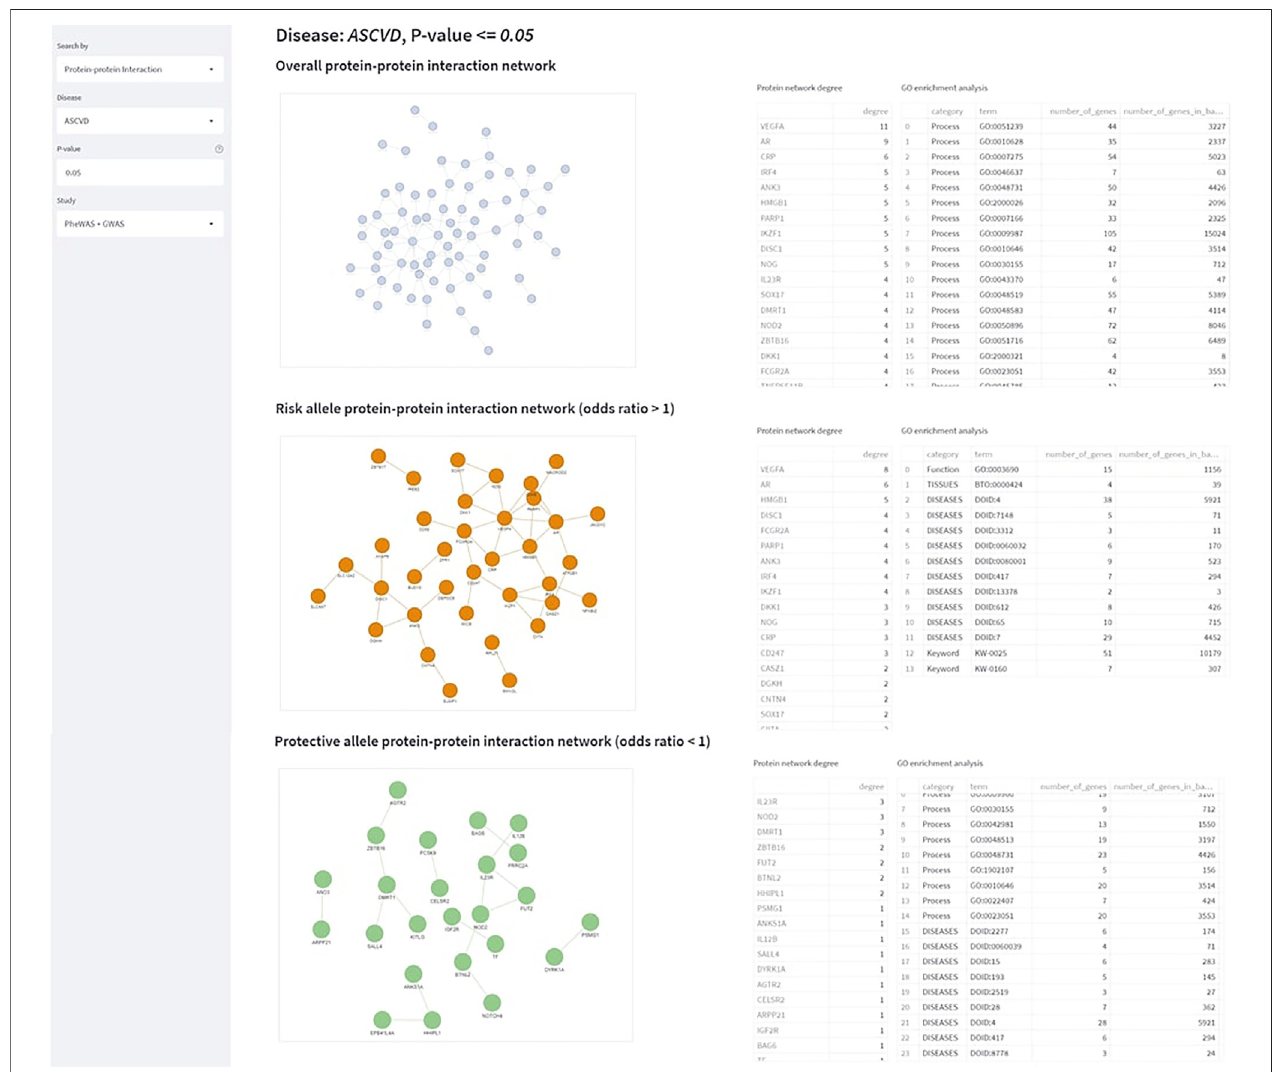
FIGURE 5 | The StarGazer interface after searching “ ASCVD ” in Protein-protein interaction mode. Protein-protein interaction networks are shown of all alleles, risk alleles, and protective alleles. The node degree of the genes of these alleles are computed, and gene ontology enrichment analysis is performed on the right.